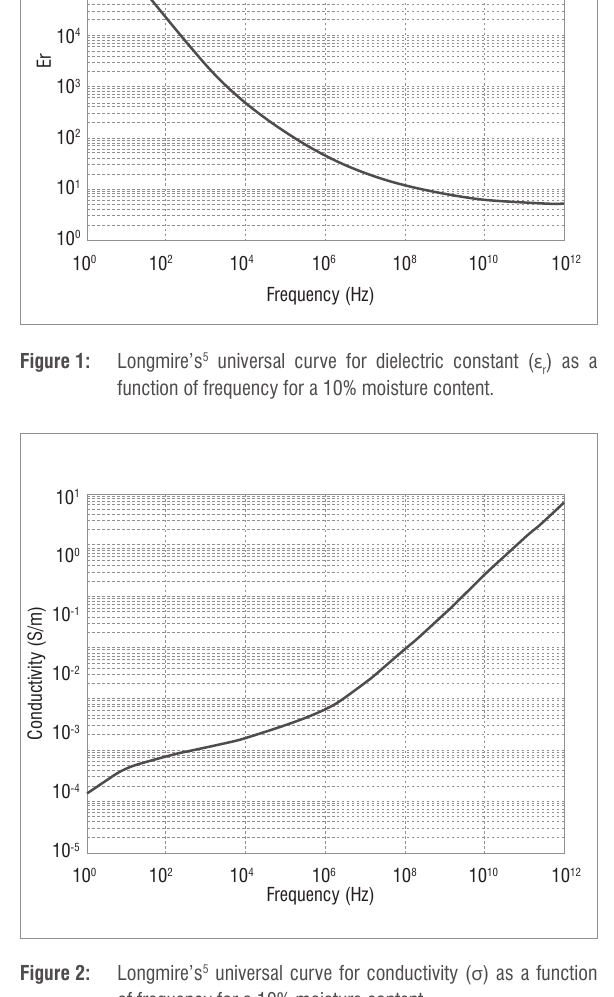
Figure 2: Longmire’s 5 universal curve for conductivity ( σ ) as a function of frequency for a 10% moisture content.